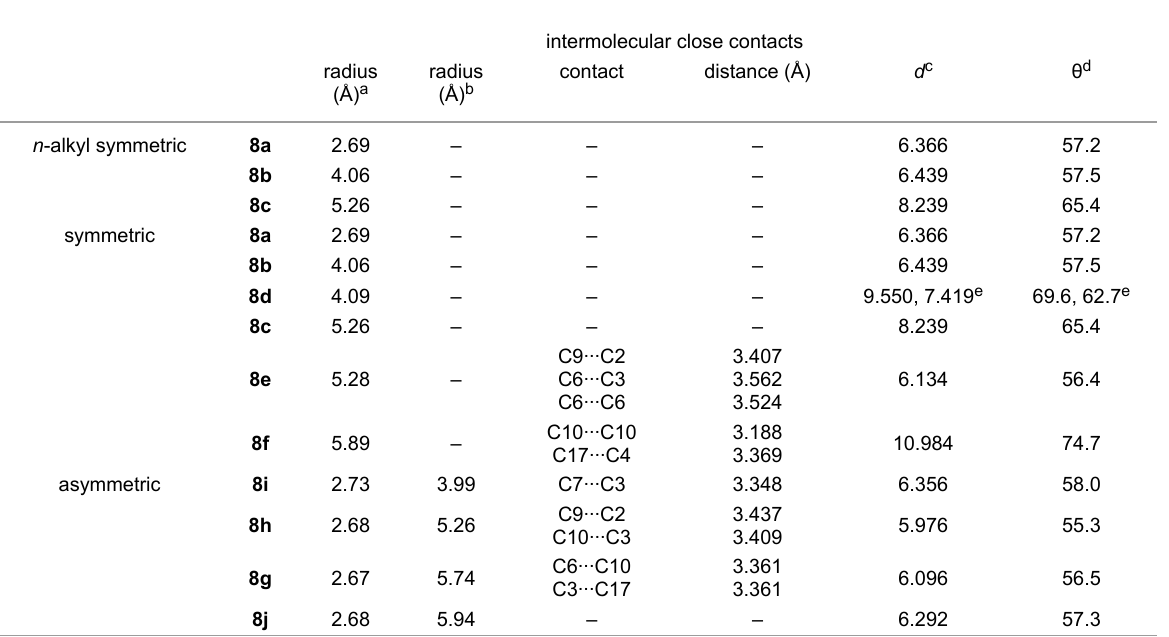
Table 4: Sizes of trisubstituted-silylethynyl groups in 8